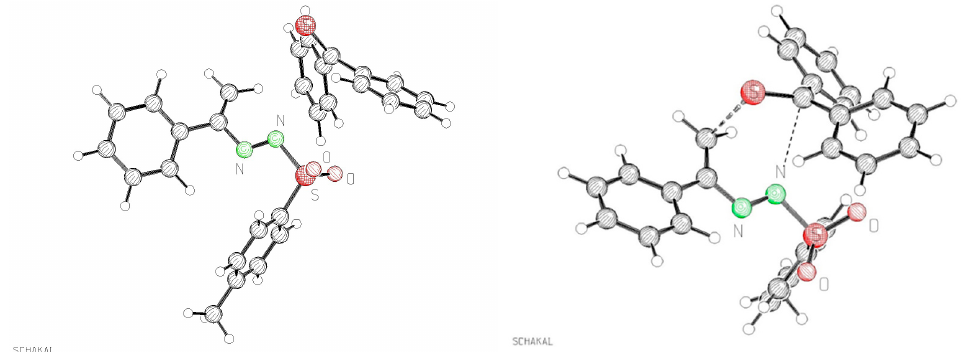
Figure 3. Van der Waals complex of azoalkene 7a and thiobenzophenone ( 1a ) ( left side) and its transition state A ( right side) leading to 1,3,4-thiadiazine derivative 9a .